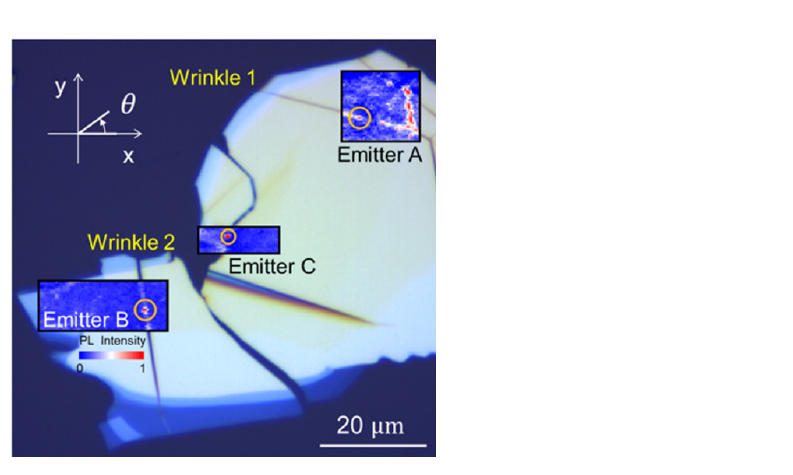
Figure 18. Microscopic image of the h-BN flake used in Yim et al.’s experiments. Reprinted (adapted) with permission from Ref. [80]. Copyright (2020) American Chemical Society.